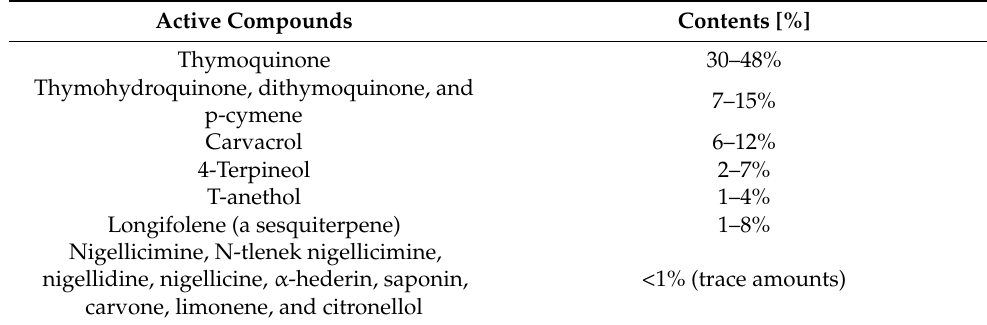
Table 2. The content of the most important bioactive compounds in the seeds of Nigella sativa